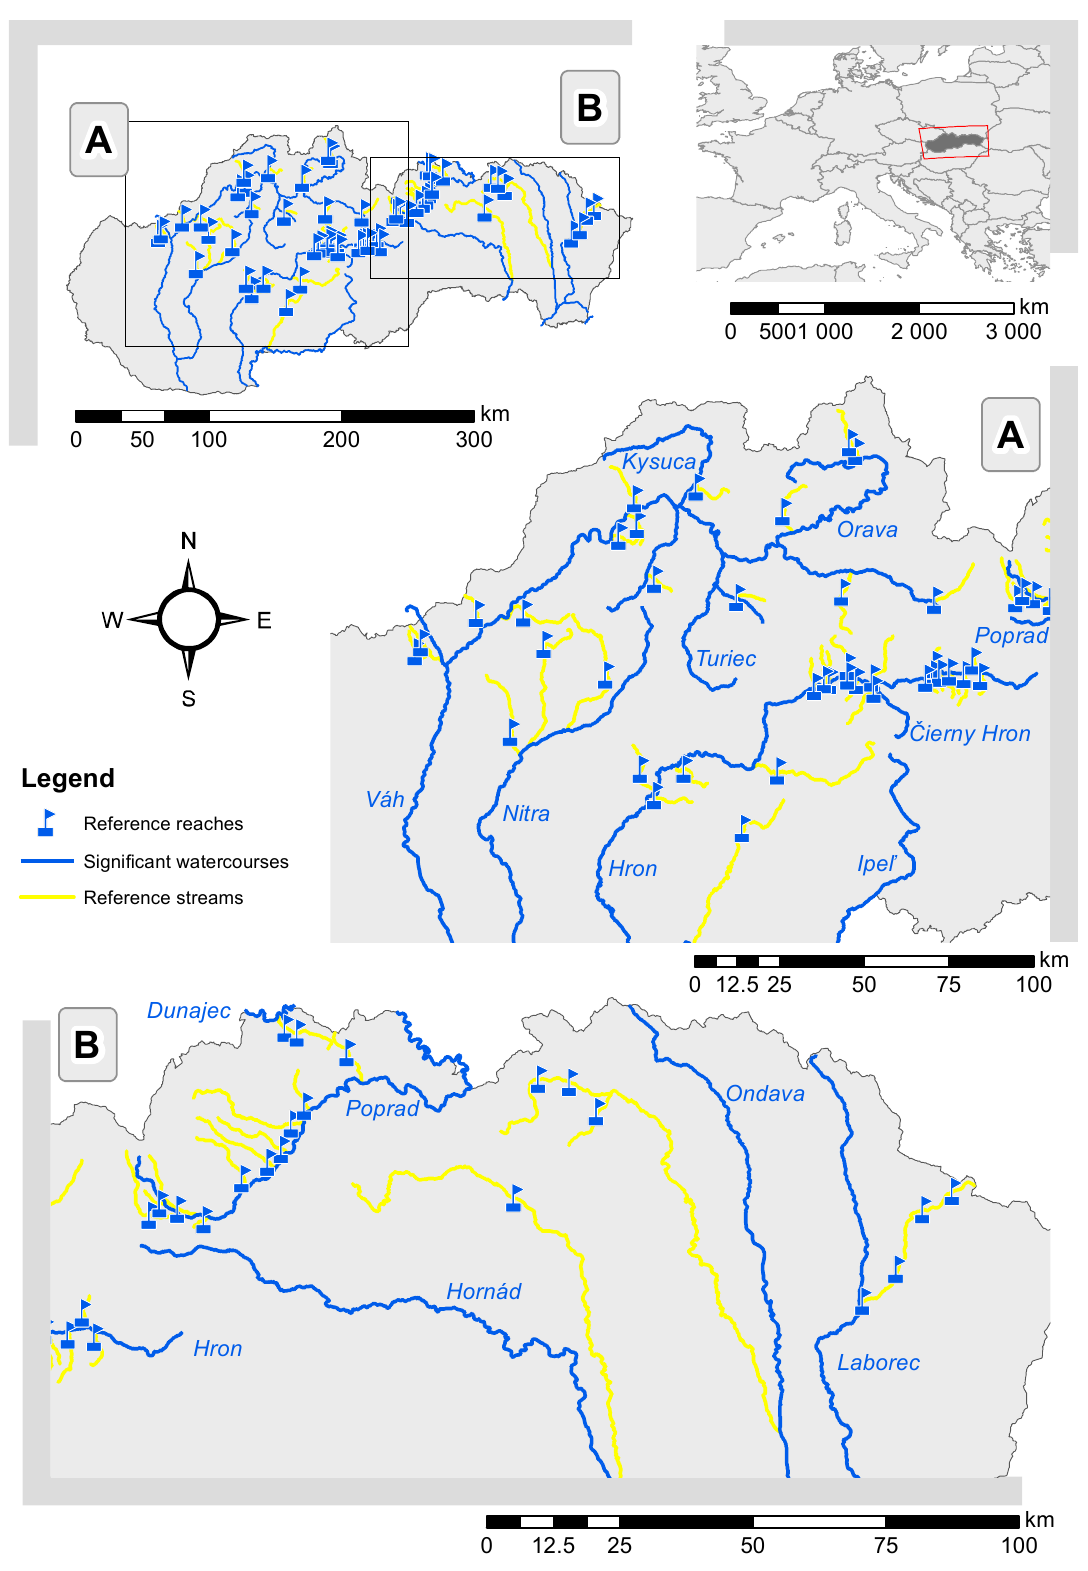
Figure 1. Location of reference reaches in streams within Slovakia. ( A ) corresponds to the A cut, and ( B ) corresponds to the B cut from the map scheme of Slovakia.